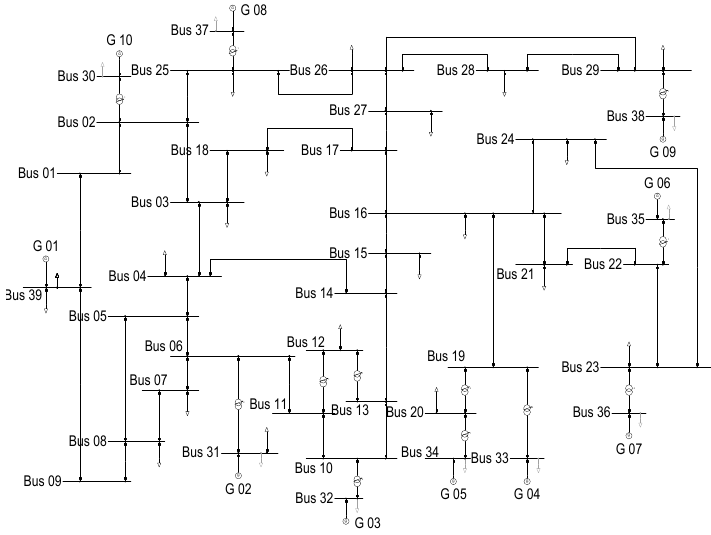
Figure 3. IEEE 39–bus power system test case.